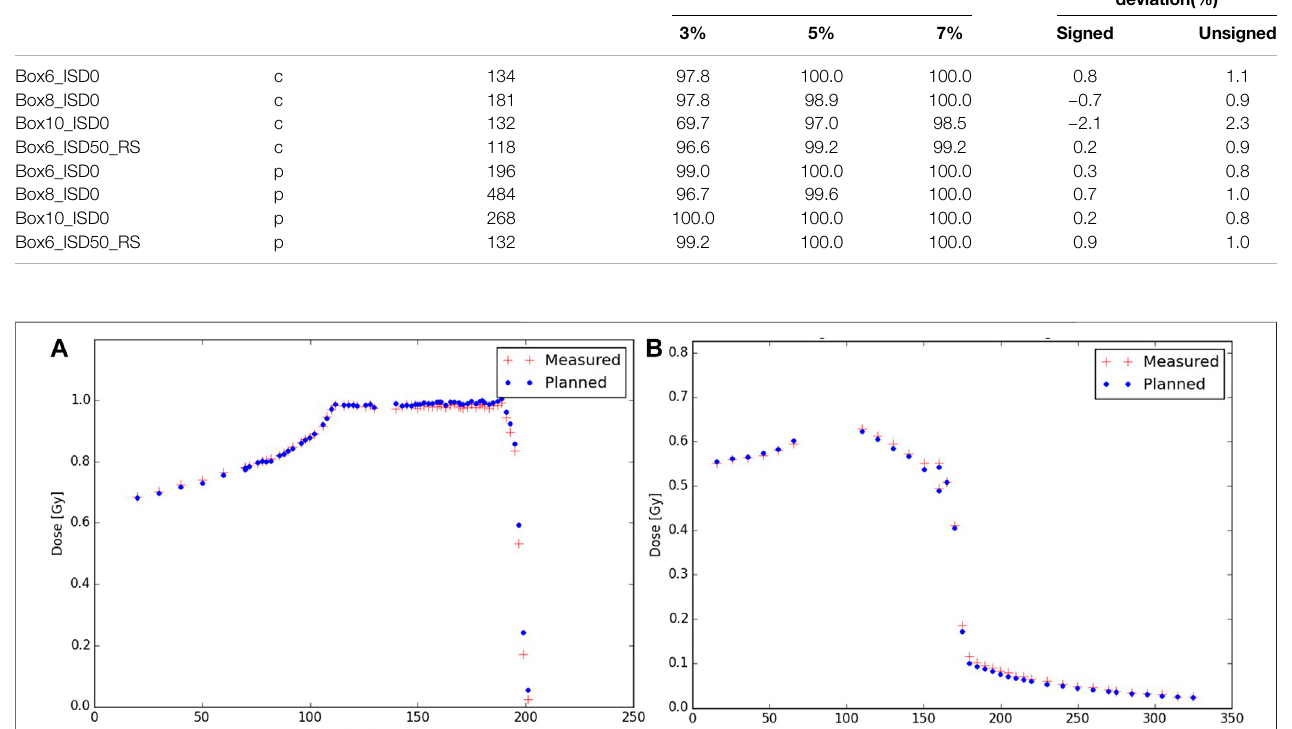
TABLE 4 | 3D validation results for the reference boxes in terms of pass-rates (considering dose difference criteria of 3%, 5% and 7%) and average dose deviations. Reference plan